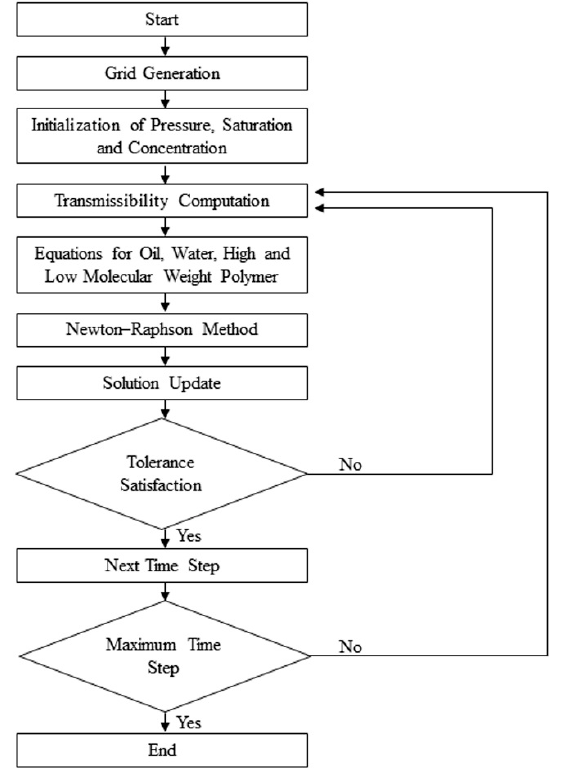
Figure 3. The solution flow chart.